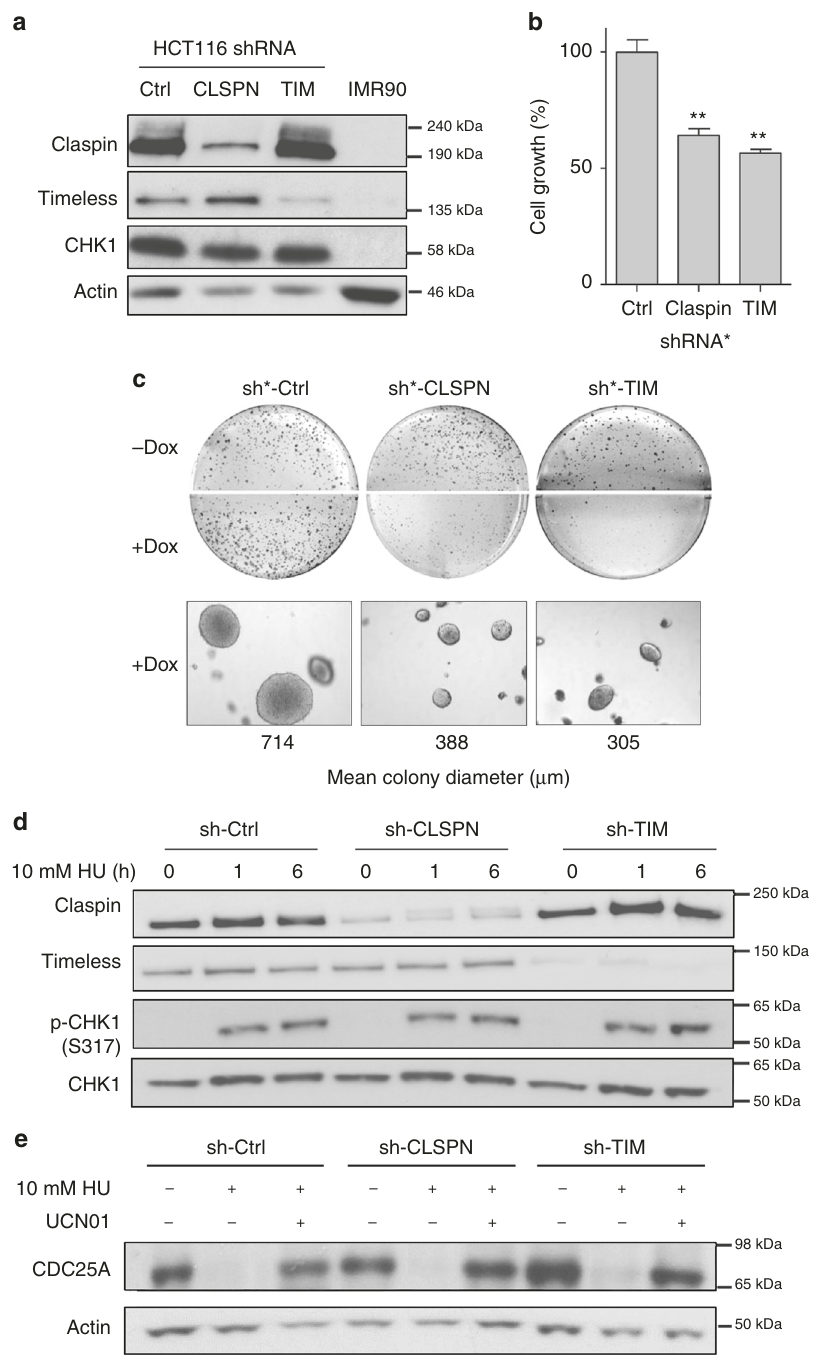
Fig. 3 The overexpression of Claspin and Timeless promotes cell growth in a checkpoint-independent manner. a Levels of Claspin, Timeless, and CHK1 in immortalized IMR90 fi broblasts and in HCT116 cells transduced with a control shRNA (sh-Ctrl) or with shRNAs against Claspin (sh-CLSPN) and Timeless (sh-TIM). b Growth of HCT116 transduced with doxycycline-inducible shRNAs against Claspin (sh*-CLSPN) or Timeless (sh*-TIM) or with a control shRNA (sh*-Ctrl). Cell growth was determined 48 h after addition of doxycyclin. ** p < 0.05. c Anchorage-independent growth assay. HCT116 cells transduced with sh*-Ctrl, sh*-CLSPN and sh*-TIM inducible shRNAs were grown 2 weeks in soft agar medium (0.7%) in the absence ( − Dox) or the presence ( + Dox) of Doxycyclin. Colonies were visualized by microscopy and mean colony size was determined with MetaMorph. Representative images are shown. d Western blot analysis of CHK1 phosphorylation (p-CHK1 and S317) in asynchronous sh-Ctrl, sh-CLSPN, and sh-TIM HCT116 cells treated for 0, 1, or 6 h with 10 mM HU. e Checkpoint-dependent degradation of CDC25A in sh-Ctrl, sh-CLSPN, and sh-TIM HCT116 cells treated for 0 or 6 h with 10 mM HU and 300 nM of the CHK1 inhibitor